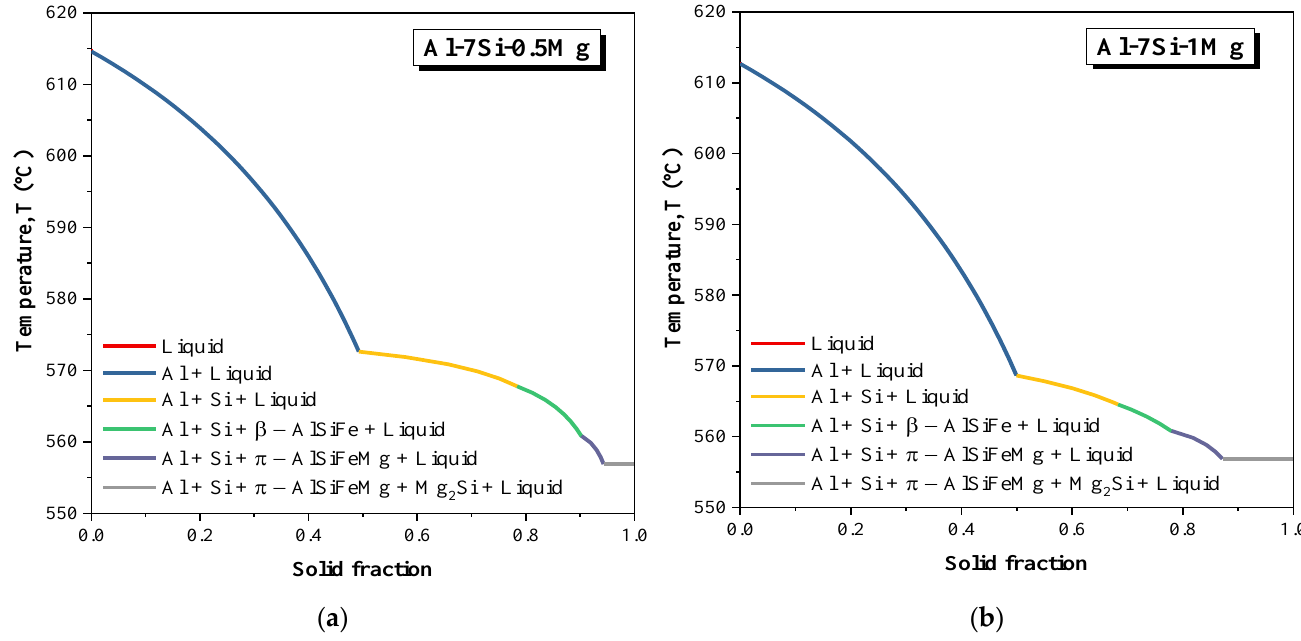
Figure 5. Scheil solidification path of the ( a ) Al-7Si-0.5Mg and ( b ) Al-7Si-1Mg alloys.